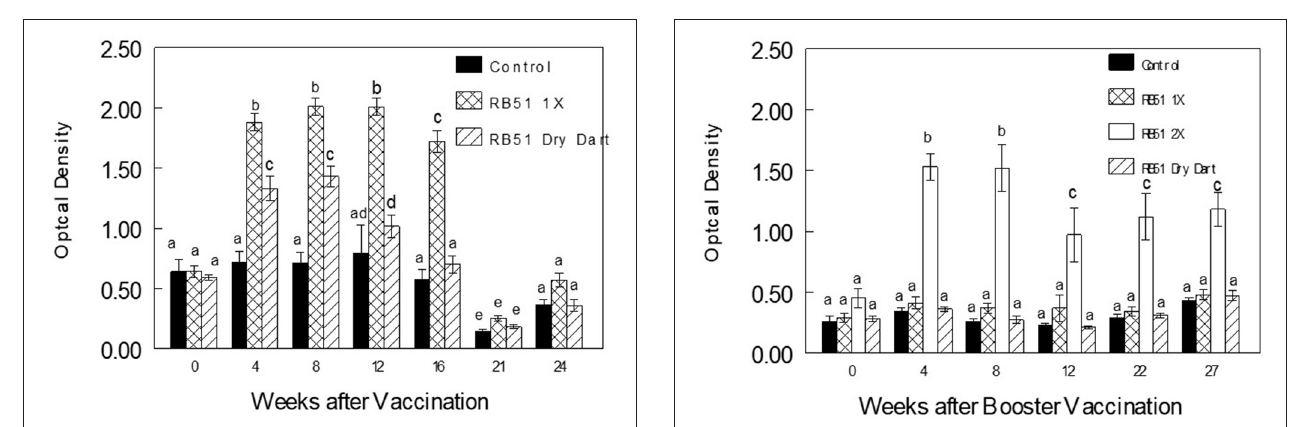
FIGURE 2 | Serologic responses of bison to γ -irradiated B. abortus strain RB51 (RB51) in an ELISA assay after administration of 10 10 CFU of RB51 to bison in the boostered vaccine treatment (RB51 2X) approximately 10 months after initial vaccination. Other treatments included non-vaccinated bison (Control), bison parenterally inoculated with a single dose of 10 10 CFU of RB51 ten months previously (RB51 1X), and bison inoculated with a novel RB51 dry dart formulation 10 months previously (RB51 Dry Dart). Responses are presented as mean titer ± SEM. Means with different superscripts are significantly different ( P < 0.05).